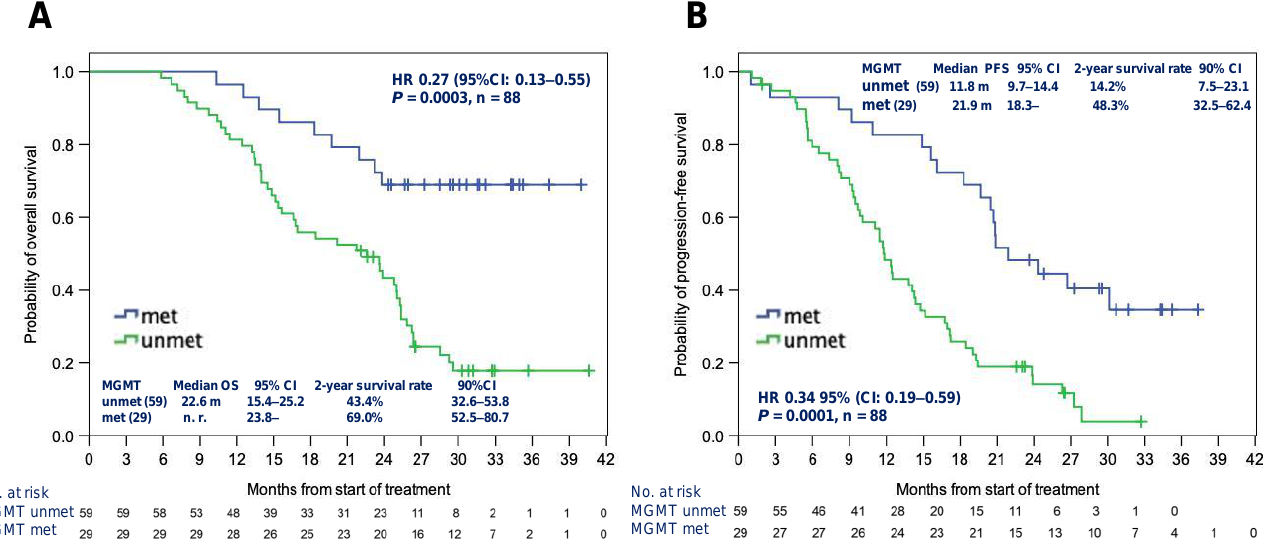
Figure 2. Median OS ( A ) and PFS ( B ) according to the MGMT methylation status in the full